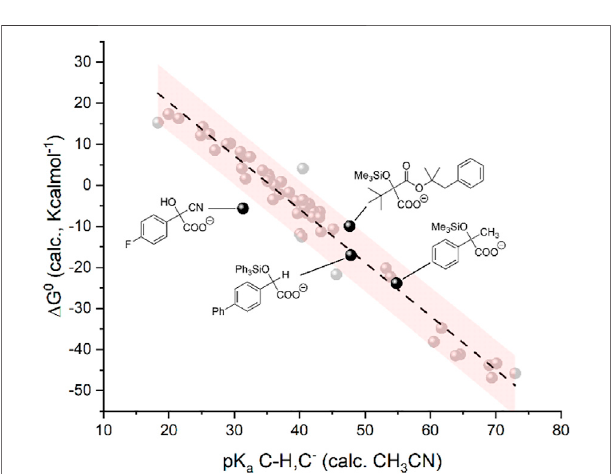
FIGURE 7 | Plot of calculated standard free energy of carboxylation ( Δ G 0 ) vs. calculated pK a of the CH/C − couples. The black dots refer to the products upon carboxylation of anions generated from activation of C (cid:1) O groups. The light gray dots indicate the same 50 organic molecules reported in Chart 1 and plotted in Figure 1